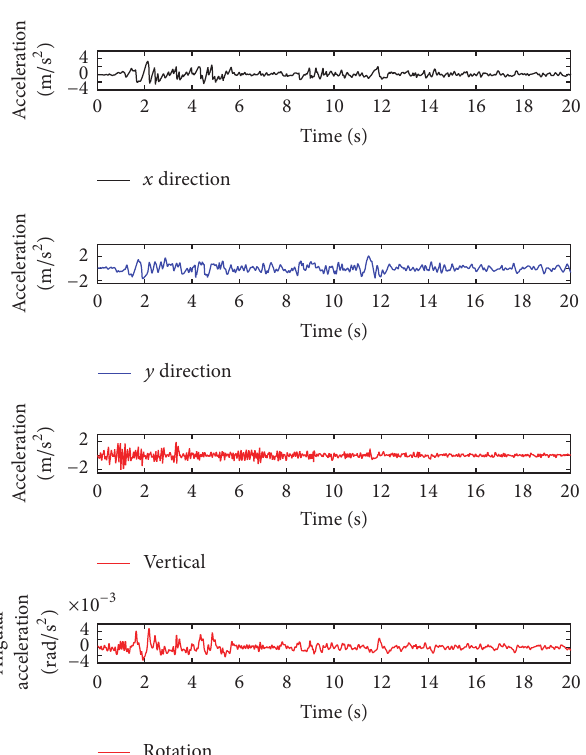
Figure 11: El Centro earthquake waves in different directions.